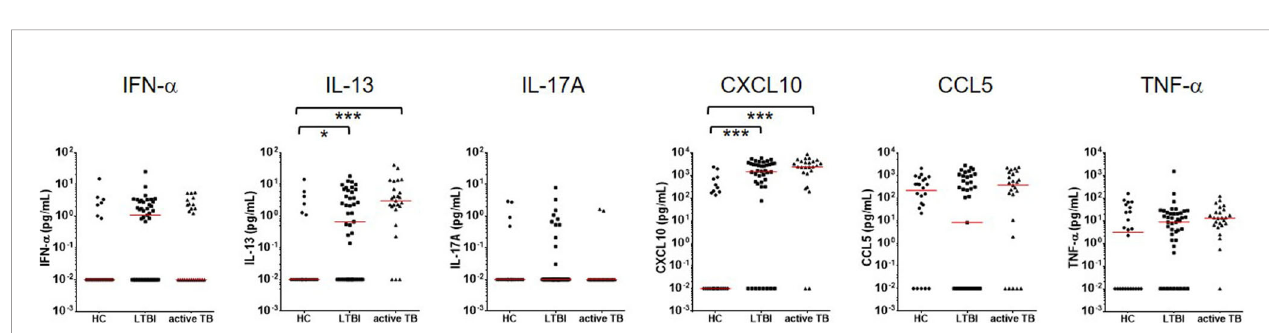
FIGURE 4 | Measurement of multiple cytokine responses to Beijing/K-combination. Among IFN- a , IL-13, IL17, CXCL10, CCL5, and TNF- a , the IL-13 and CXCL10 responses were signi fi cantly higher in LTBI and active TB compared with HC (antigen minus nil). However, disease status (active TB vs. LTBI) was not differentiated by the cytokine/chemokine responses. The median responses are marked by red lines. *P < 0.05, ***P < 0.001 by one-way ANOVA with subsequent Kruskal-Wallis test, HC, healthy control.